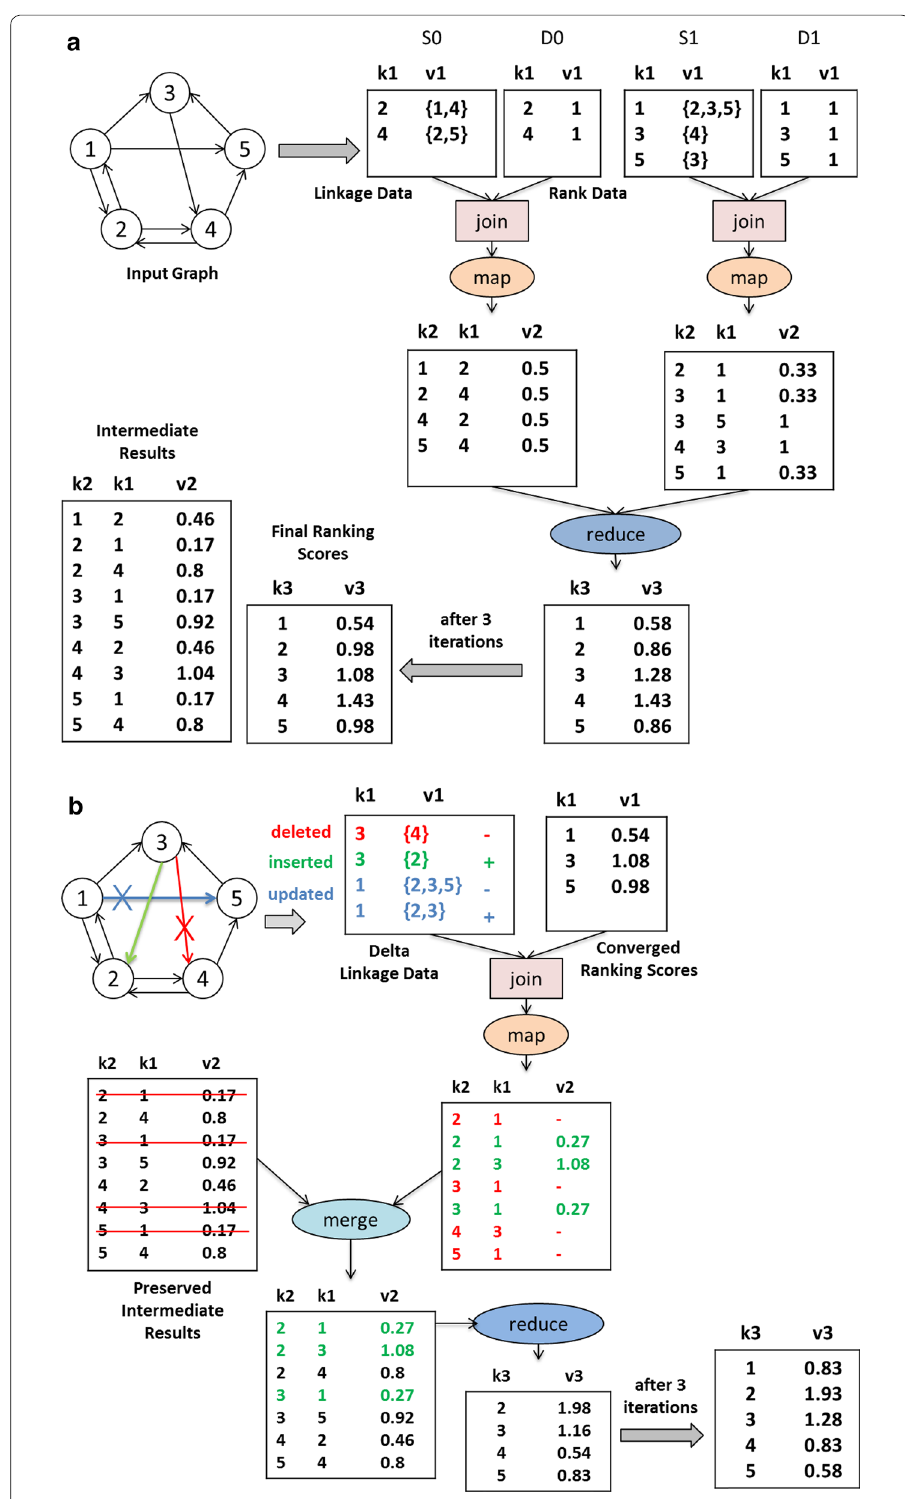
Fig. 3 Incremental iterative processing for PageRank. a Iterative execution. b Incremental